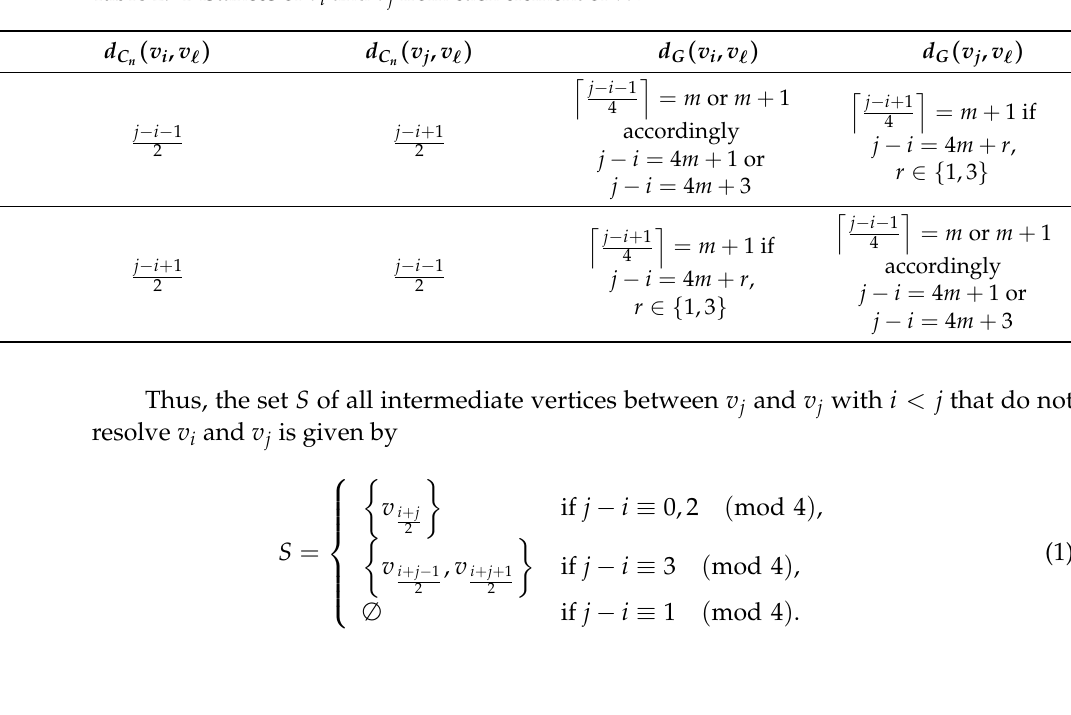
Table 2. Distances of v i and v j from each element of W